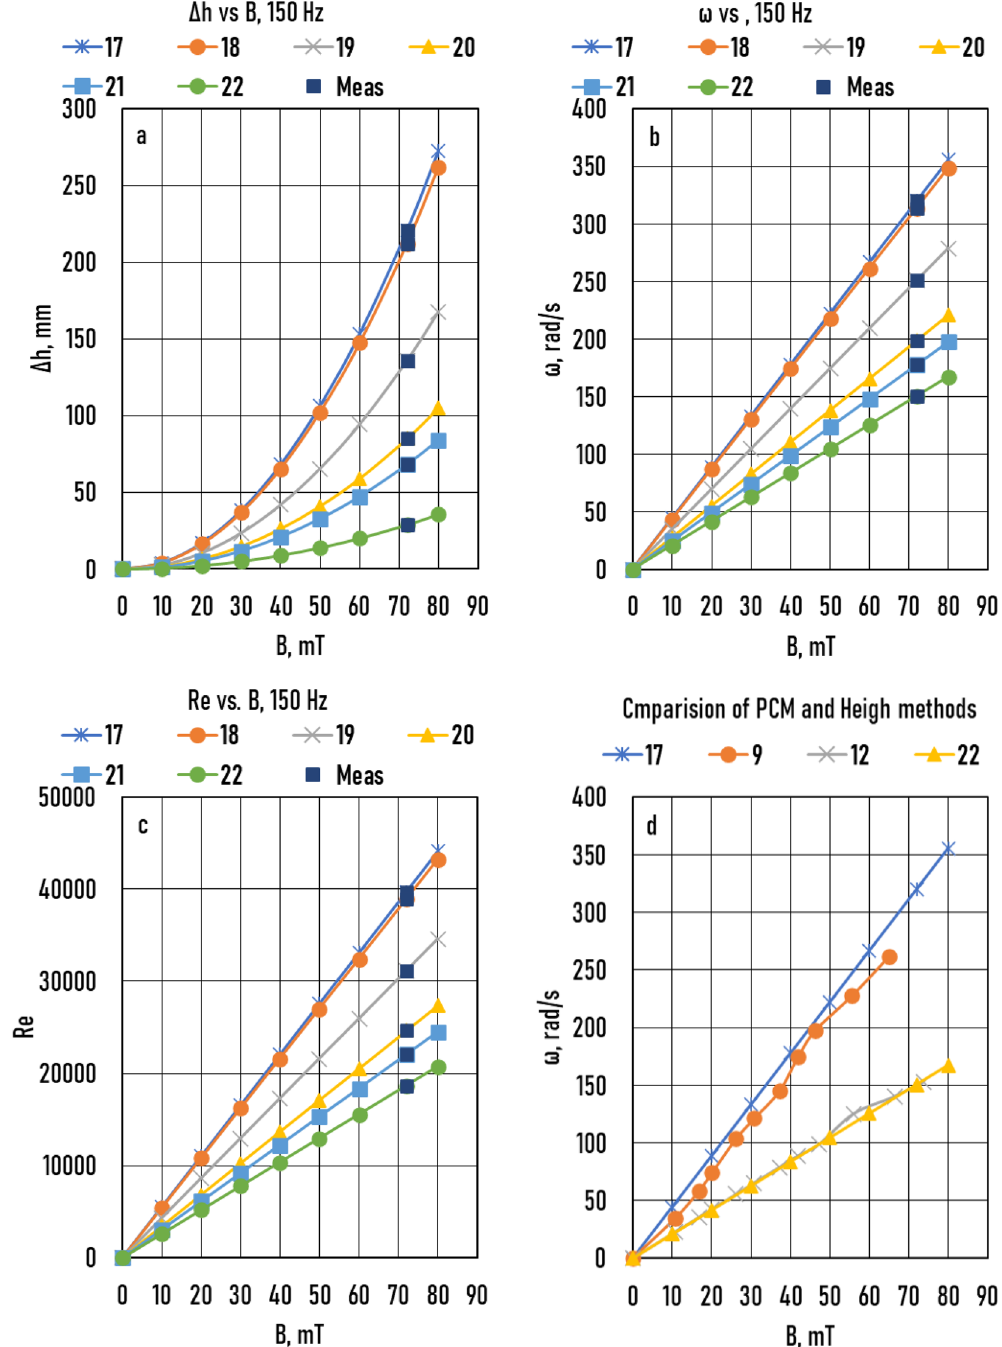
Figure 7. Samples 17 – 22 ( a ) Measured height ( Δh ) as a function of magnetic induction ( B ). ( b ) Angular frequency of melt ( ω ) as a function of B . ( c ) The real Reynolds number ( Re ) as a function of B . ( d ) Comparison of the pressure compensation method (PCM) and height measuring method